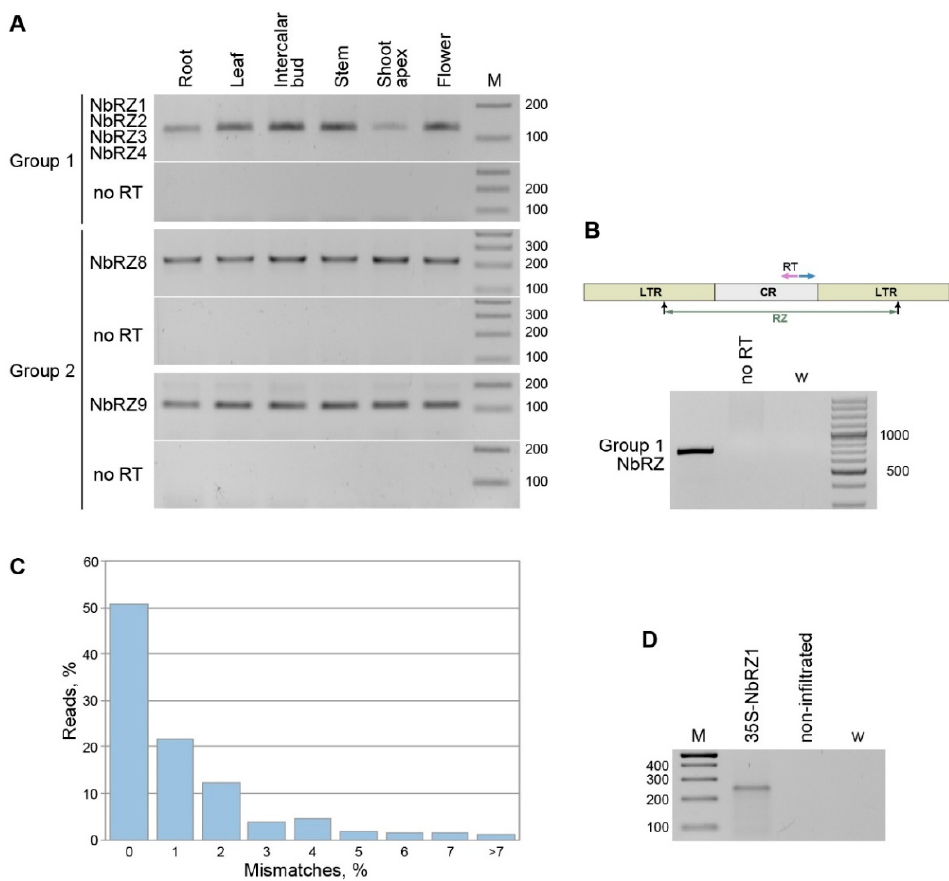
Figure 2. Analysis of retrozyme RNA in N. benthamiana plants. ( A ) Detection of retrozymes RNA in different plant parts, which are indicated above the gel. The specificity of the primers used and the retrozyme groups analyzed are indicated on the left. M—DNA size markers. ( B ) Percentage of retrozyme-specific reads with different numbers of mismatches with the closest genomic sequences. ( C ) Detection of full-length circular/concatemeric retrozyme RNA with a pair of divergent primers specific for Group 1 NbRZ. Positions of primers are shown by arrows on the retrozyme schematic representation above the gel. RT indicates the primer used for reverse transcription. ( D ) 5 ′ -RACE analysis of NbRZ1-specific linear RNA in N. benthamiana leaves infiltrated with agrobacteria carrying the 35S-NbRZ1 construct and non-infiltrated leaves. W (water)—a control PCR without template added. M—DNA size markers.